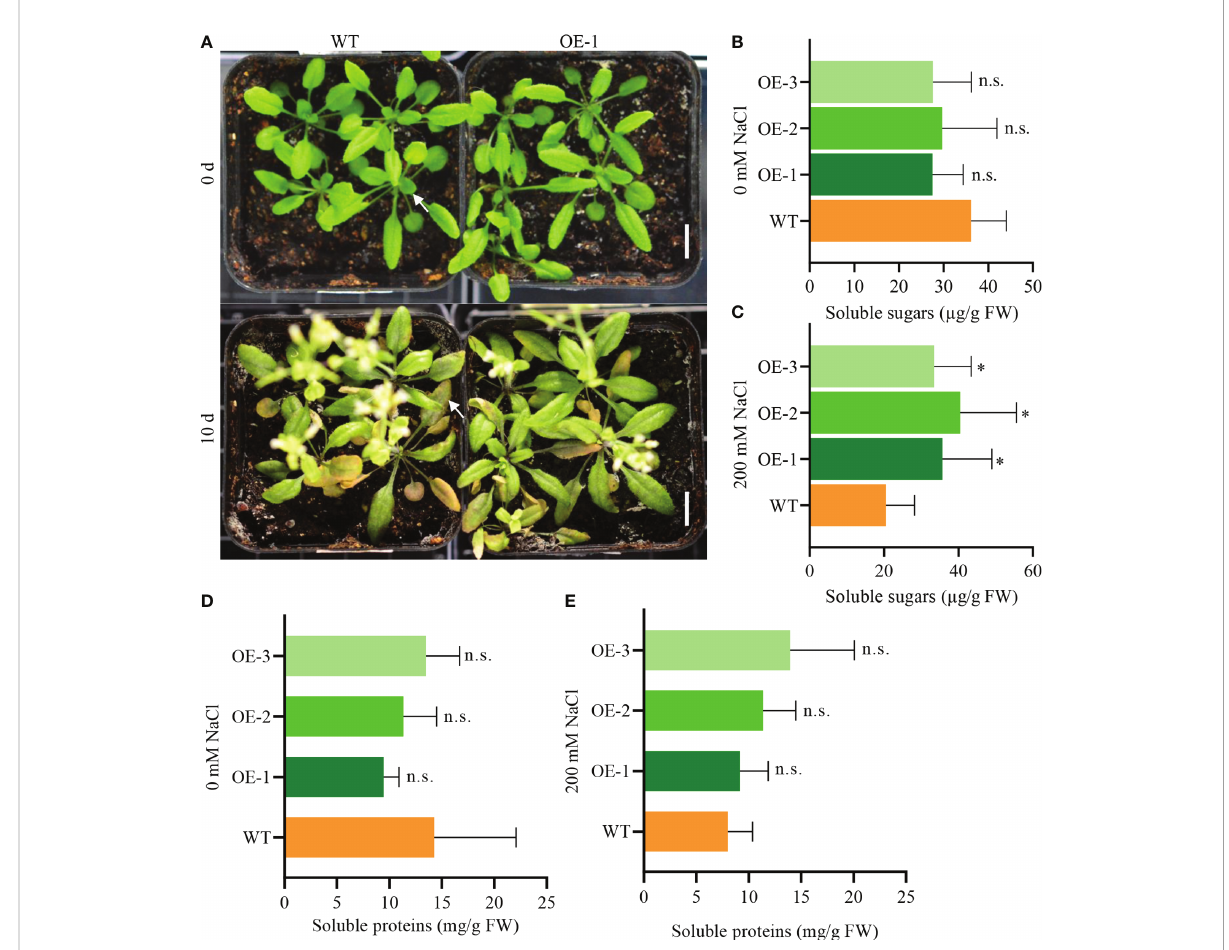
FIGURE 10 NbCIPK25 promotes soluble sugar accumulation under salt treatment. (A) Phenotypes of salt-treated seedlings in pots for 0 and 10 days. Scale bar: 1 cm. (B, C) Soluble sugar content under normal condition (B) and 200 mM NaCl treatment (C) . (D, E) Soluble protein content under normal condition (D) and 200 mM NaCl treatment (E) . Data represent means ± SD from three biological replicates, t-test was used for statistical analysis, ‘ * ’ p < 0.05, n.s., not signi fi